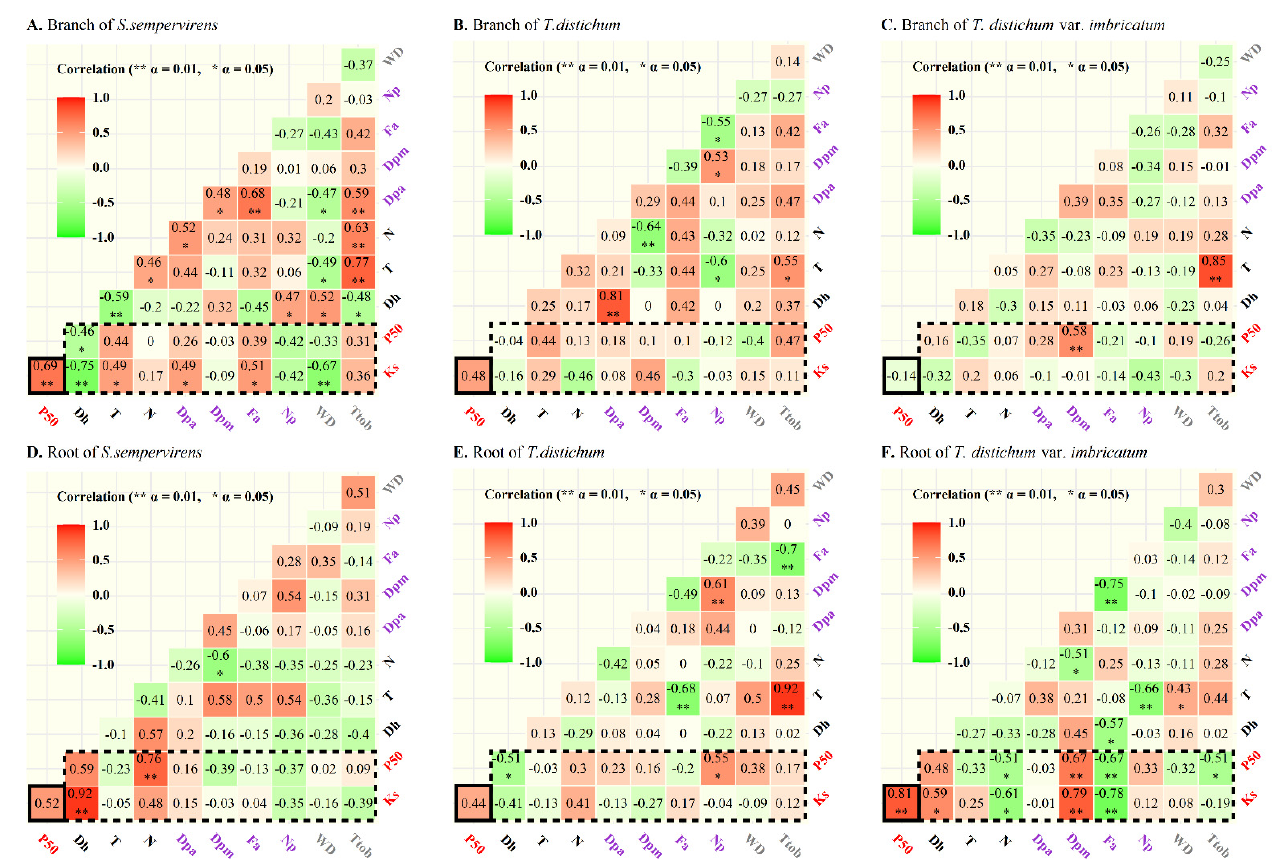
Figure 6. Correlations between the xylem structural and functional traits ( K s and P 50 ) in the branches and roots within taxa. ( A ): Branch of S. sempervirens ; ( B ): Branch of T. distichum ; ( C ): Branch of T. distichum var. imbricatum ; ( D ): Root of S. sempervirens ; ( E ): Root of T. distichum ; ( F ): Root of T. distichum var. imbricatum . K s : Specific conductivity; P 50 : Water potential in the xylem of branches and roots corresponding to a loss in water conductivity of 50%; D h : Hydraulic diameter; T : Tracheid wall thickness; N : Tracheid density; D pa : Pit aperture diameter; D pm : Pit membrane diameter; F a : Aperture opening ratio; N p : Pit density; WD: Wood density; and Ttob : Thickness-to-span ratio. *, 0.01 < p < 0.05; **, p < 0.01.